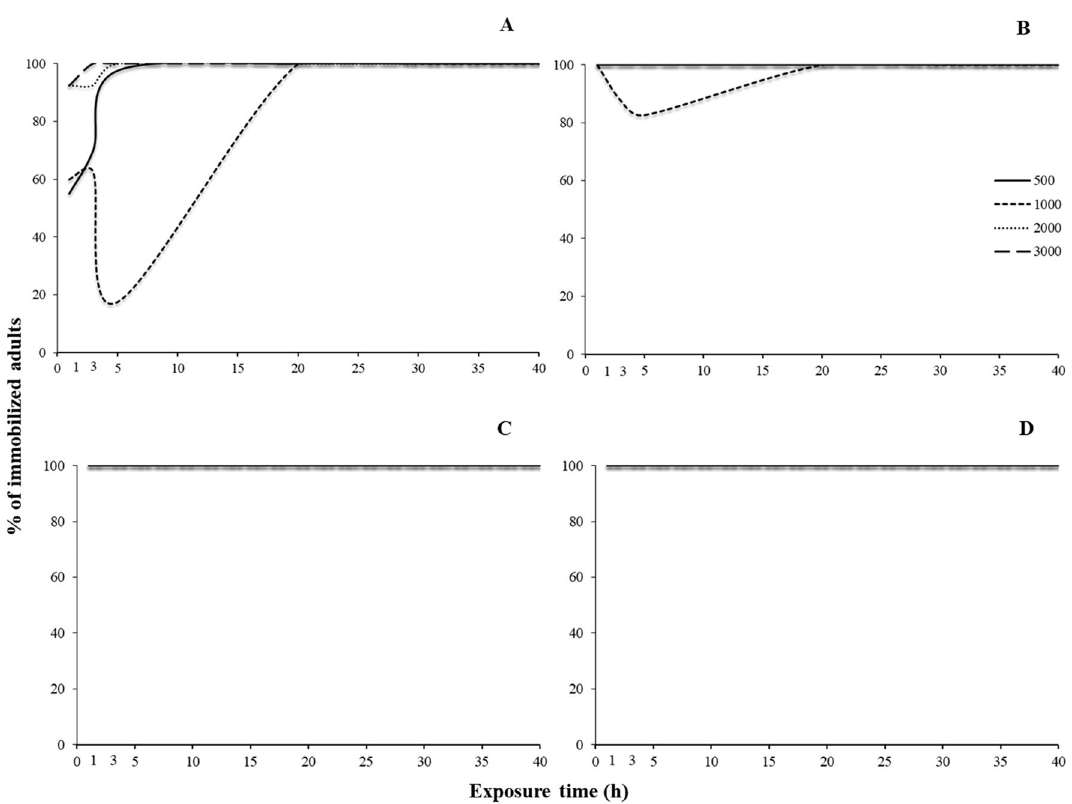
Figure 4. Percentage (%) of immobilized adults of laboratory populations of R. dominica ( A ), S. oryzae ( B ), O. surinamensis ( C ) and T. castaneum ( D ), for different exposure time (1, 3, 5, 20, 30 and 40 h) and different concentrations of phosphine (500, 1000, 2000 and 3000 ppm). The equations for each exposure interval for each species are presented in Table